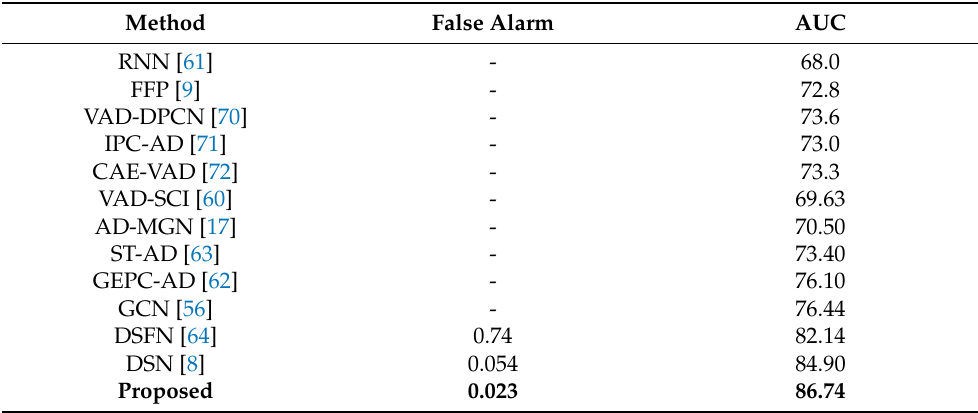
Table 2. Performance comparison of the proposed model with other SOTA over ShanghaiTech dataset.